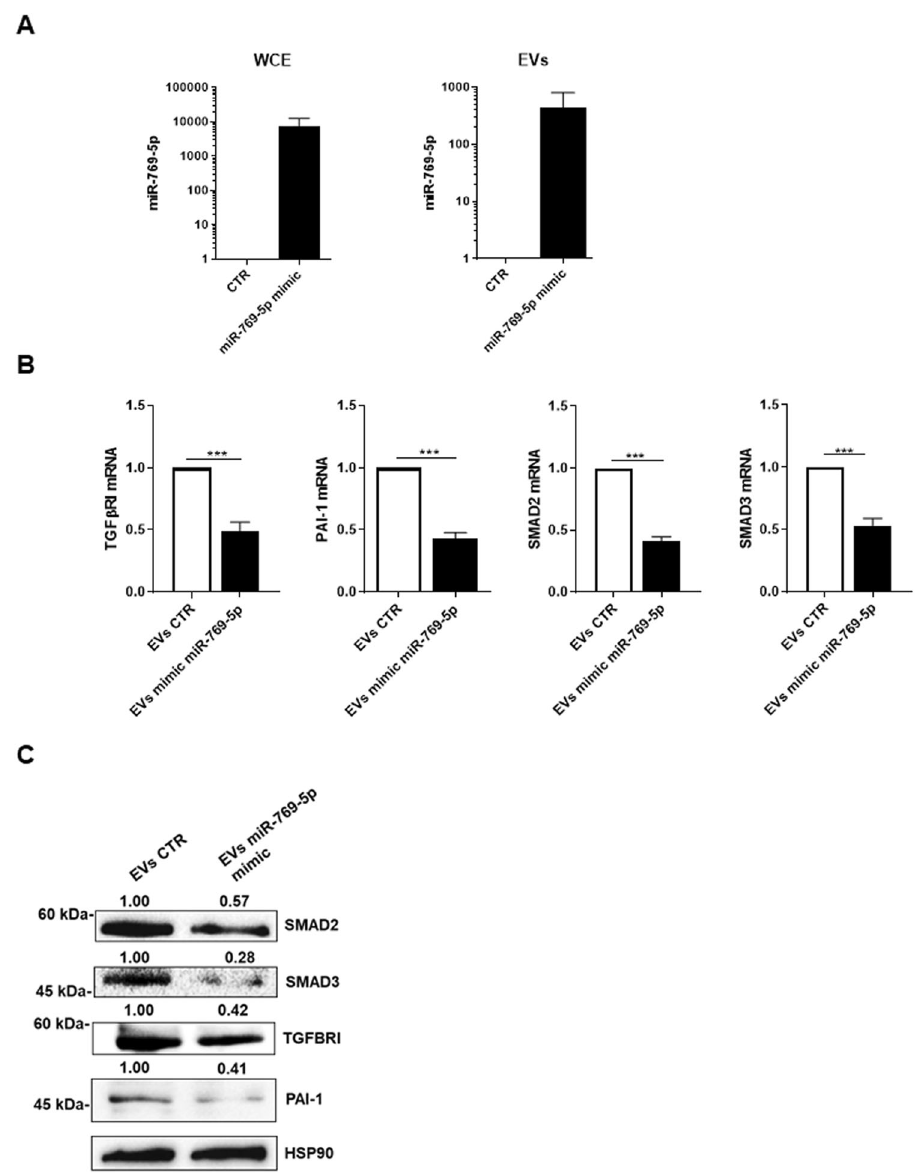
Fig. 6 EV transfer of miR-769-5p promotes MMT reversal. A RT-PCR showing expression of miR769-5p in whole cell extract (WCE) ( left ) or the EV fraction ( right ) upon miR769-5p ectopic expression in primary MCs from PD patients. miR-16 was used for normalization. Bars represent the mean ± SEM of duplicate determinations in three independent experiments B RT-PCR showing expression of TGF β 1, PAI-1, SMAD2 and SMAD3 mRNA from total RNA of recipient MCs after treatment with EVs (10 μ g) from MCs transfected with control or mimic miR769-5p. Bars represent the mean ± SEM of duplicate determinations in six independent experiments. C WB showing the expression of Smad2, Smad3, TGFBRI and PAI-1 in MCs from PD patients after treatment with EVs expressing miR769-5p (generated as Fig. 6A). Hsp90 was used as a loading control. Data are representative of three independent